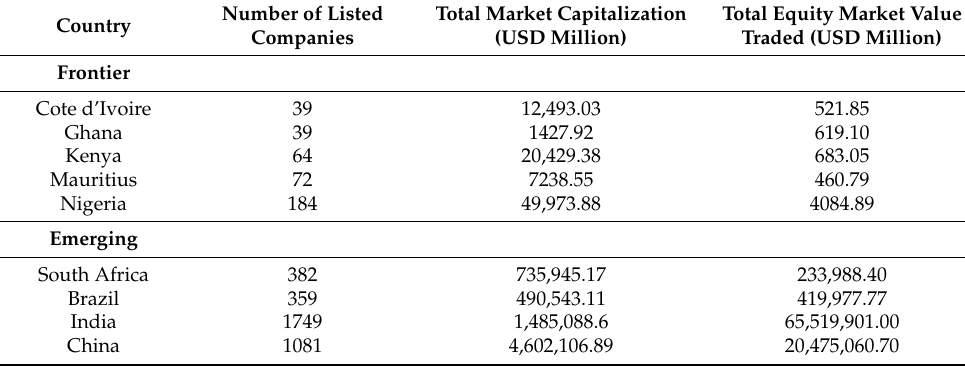
Table 1. Frontier vs. emerging